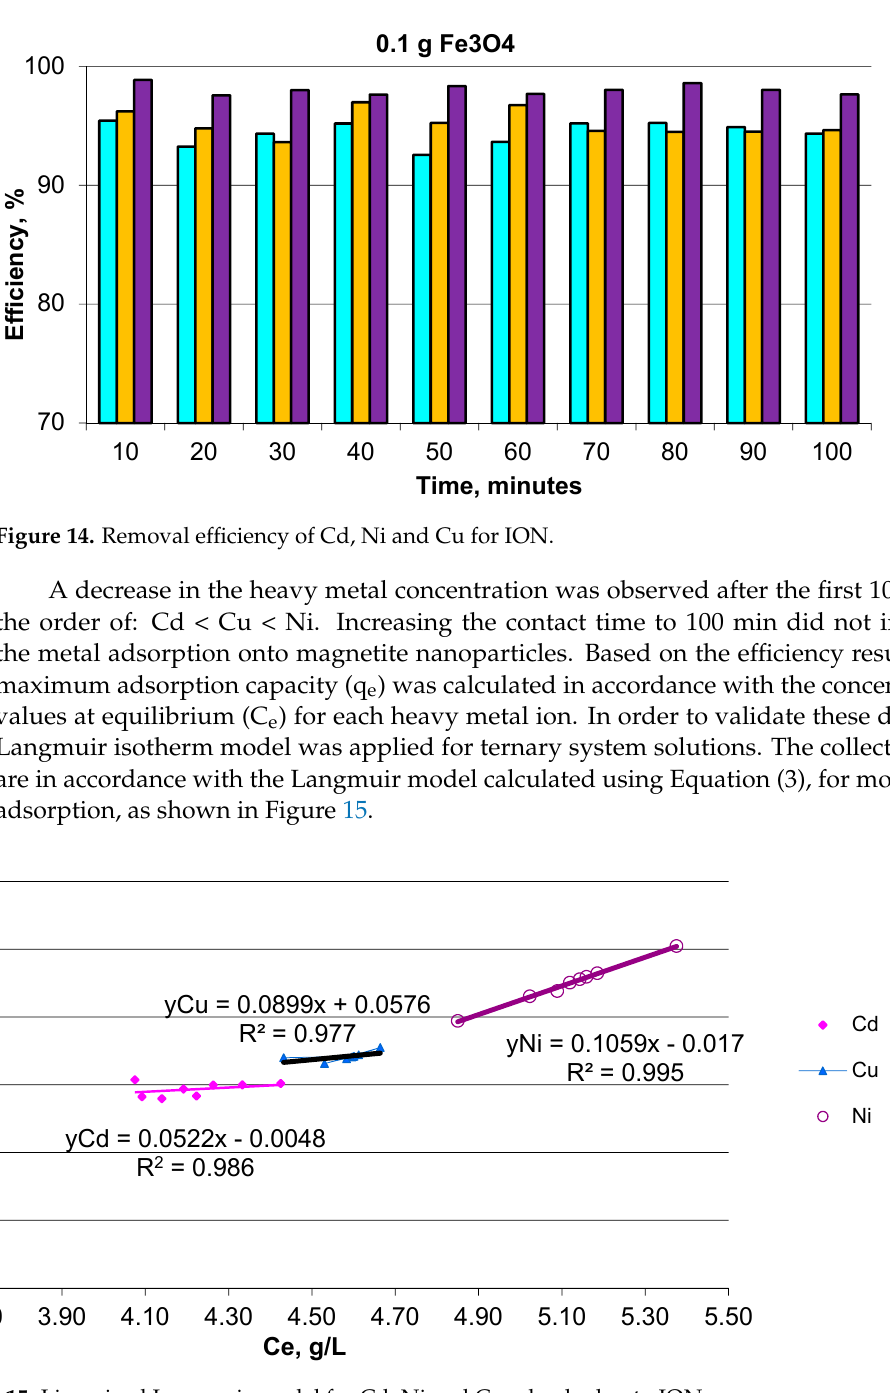
Figure 15. Linearized Langmuir model for Cd, Ni and Cu adsorbed onto ION. According to the Langmuir isotherm, the q e values are: 9.44 mg/g (Ni), 11.12 mg/g (Cu) and 19.15 mg/g (Cd). The correlation factor (R 2 ) indicates a good fitting of the results